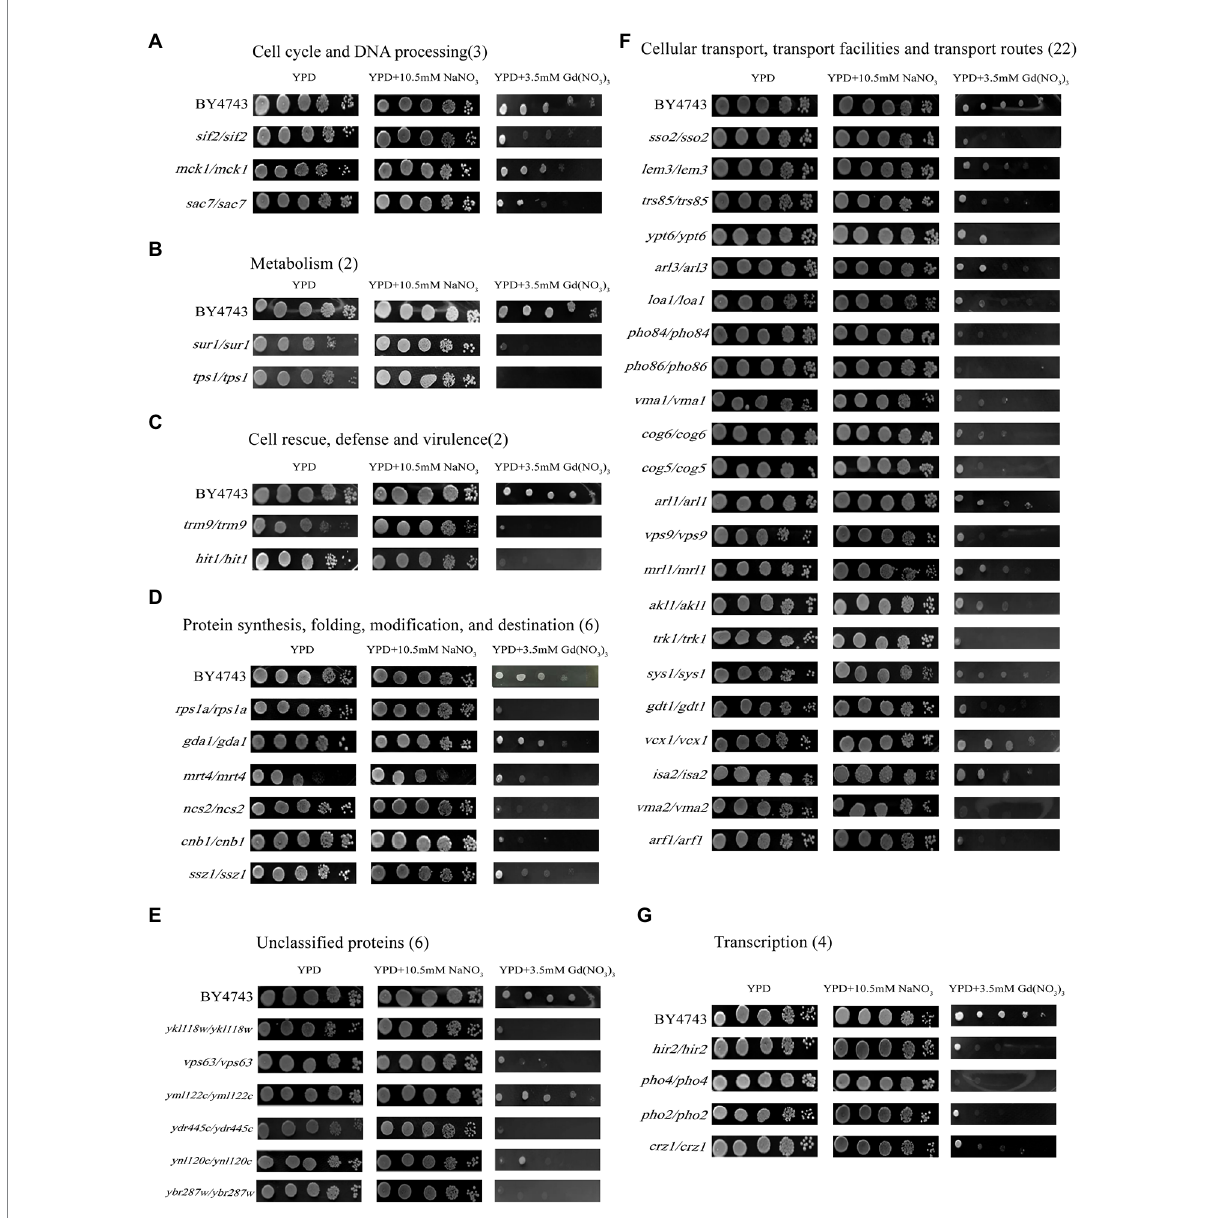
FIGURE 2 Phenotypes of Gd-sensitive gene deletion mutants. Five yeast culture diluents (10 − 0 , 10 − 1 , 10 − 2 , 10 − 3 , 10 − 4 ) were put on the YPD solid medium containing 0, 3.5 mM Gd(NO 3 ) 3 , and 10.5 mM NaNO 3 , respectively. Cells of the wild-type BY4743 and 45 gene deletion mutants were identified from the genome-scale screen, and functional categories of the genes corresponding to the sensitive phenotypes were classified. (A) DNA processing and cell cycle (3 genes); (B) Metabolism (2 genes); (C) Cell rescue, virulence, and defense (2 genes); (D) Protein synthesis, modification, folding, and destination (6 genes); (E) Unclassified proteins (6 genes); (F) Cellular transport, transport routes, and transport facilities (22 genes); (G) Transcription (4 genes). The experiment was repeated three